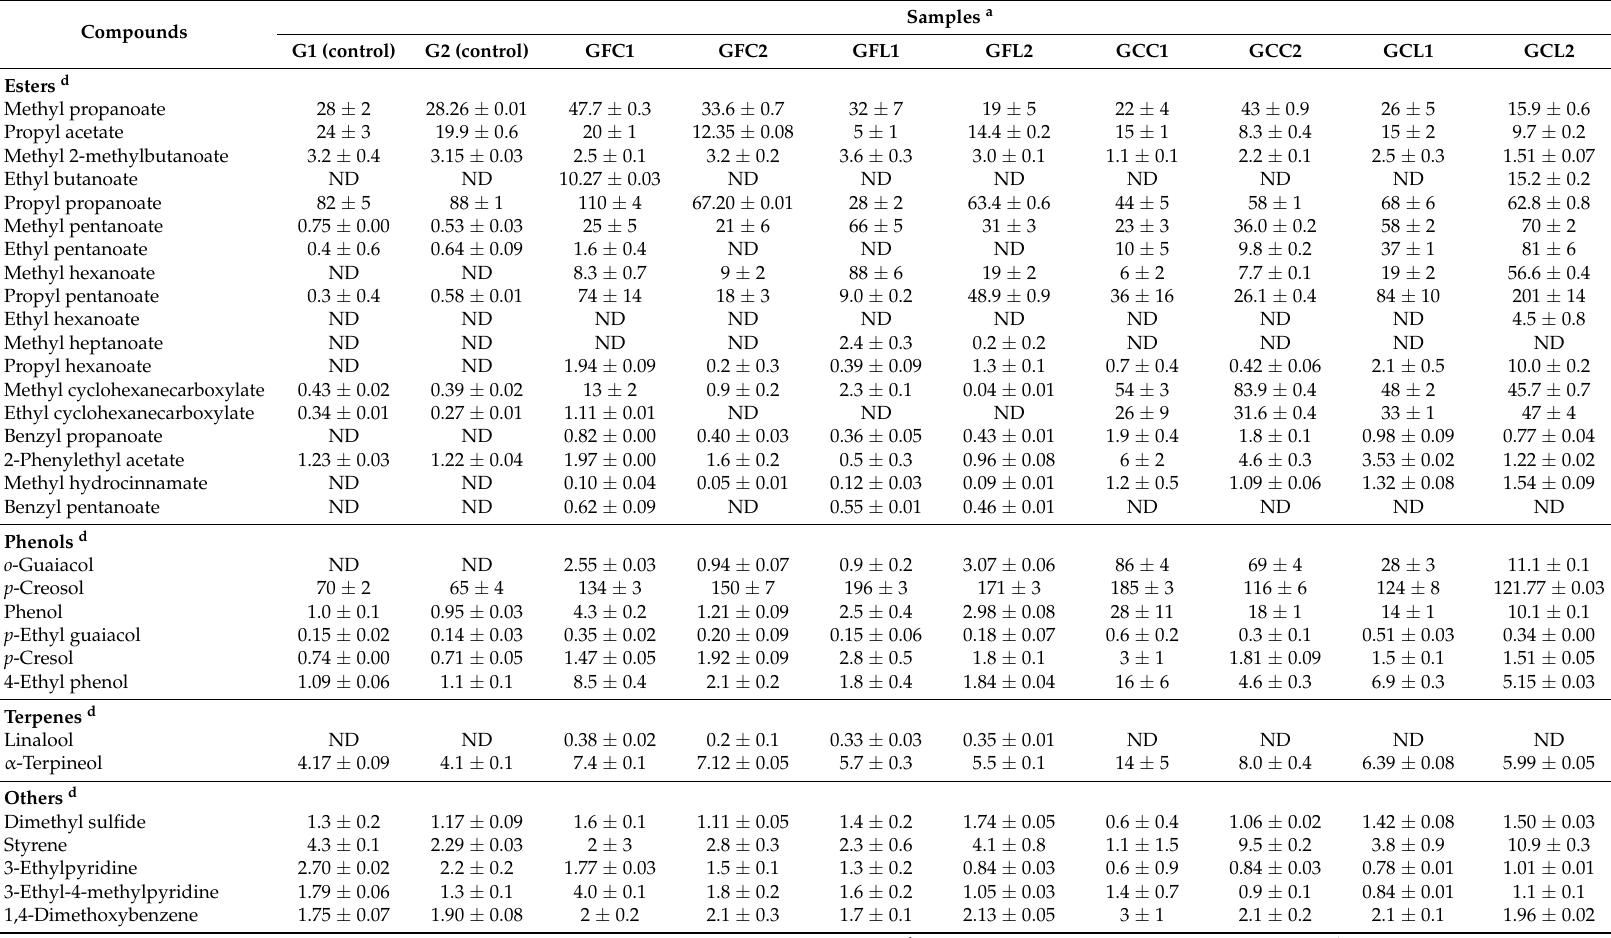
a Values are means ± SD. ND = not detected. See Table 5 for the meanings of samples abbreviations. b Quantitative determination expressed in g L − 1 . c Quantitative